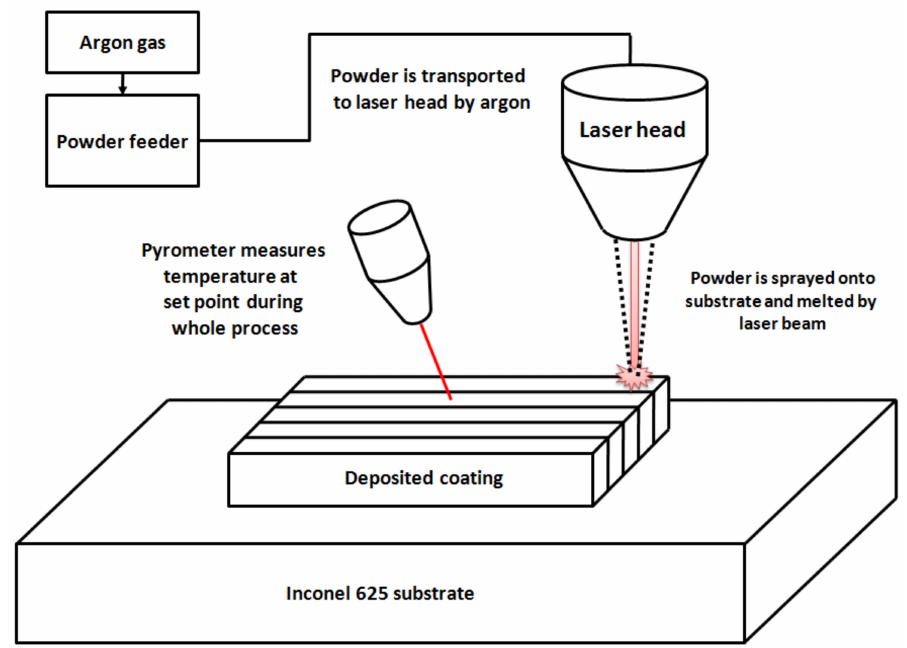
Figure 2. Schematic representation of the laser metal deposition process.